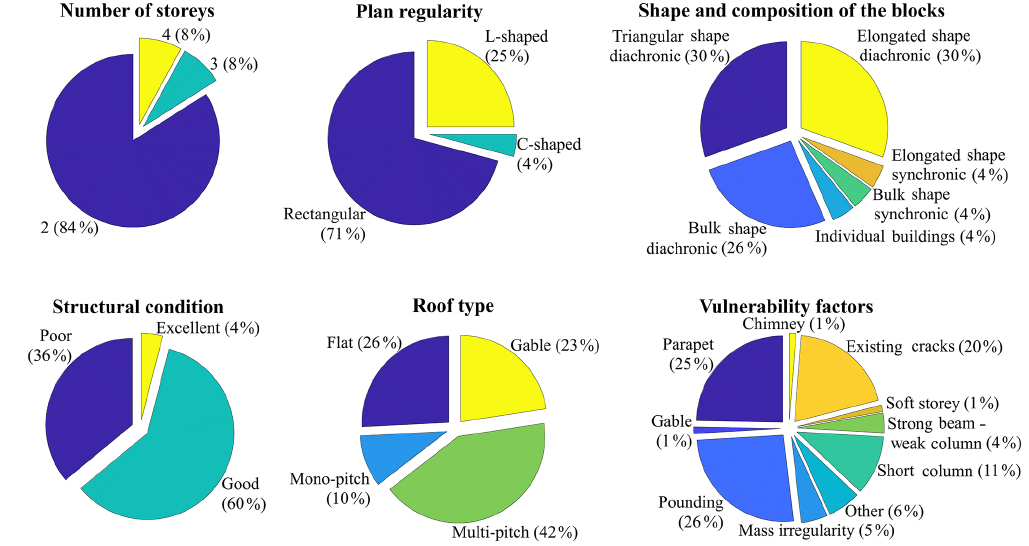
Figure 7. Statistics for the 25 surveyed CH buildings, Iloilo City,